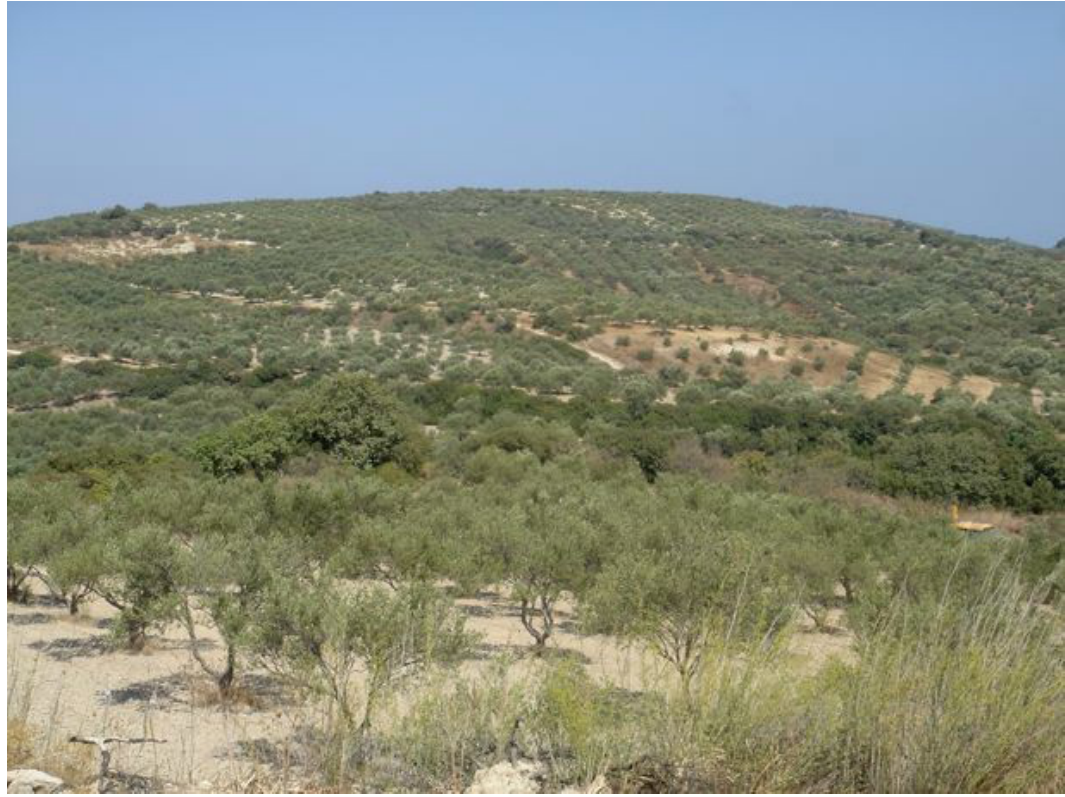
Figure 2. Olive plantations in